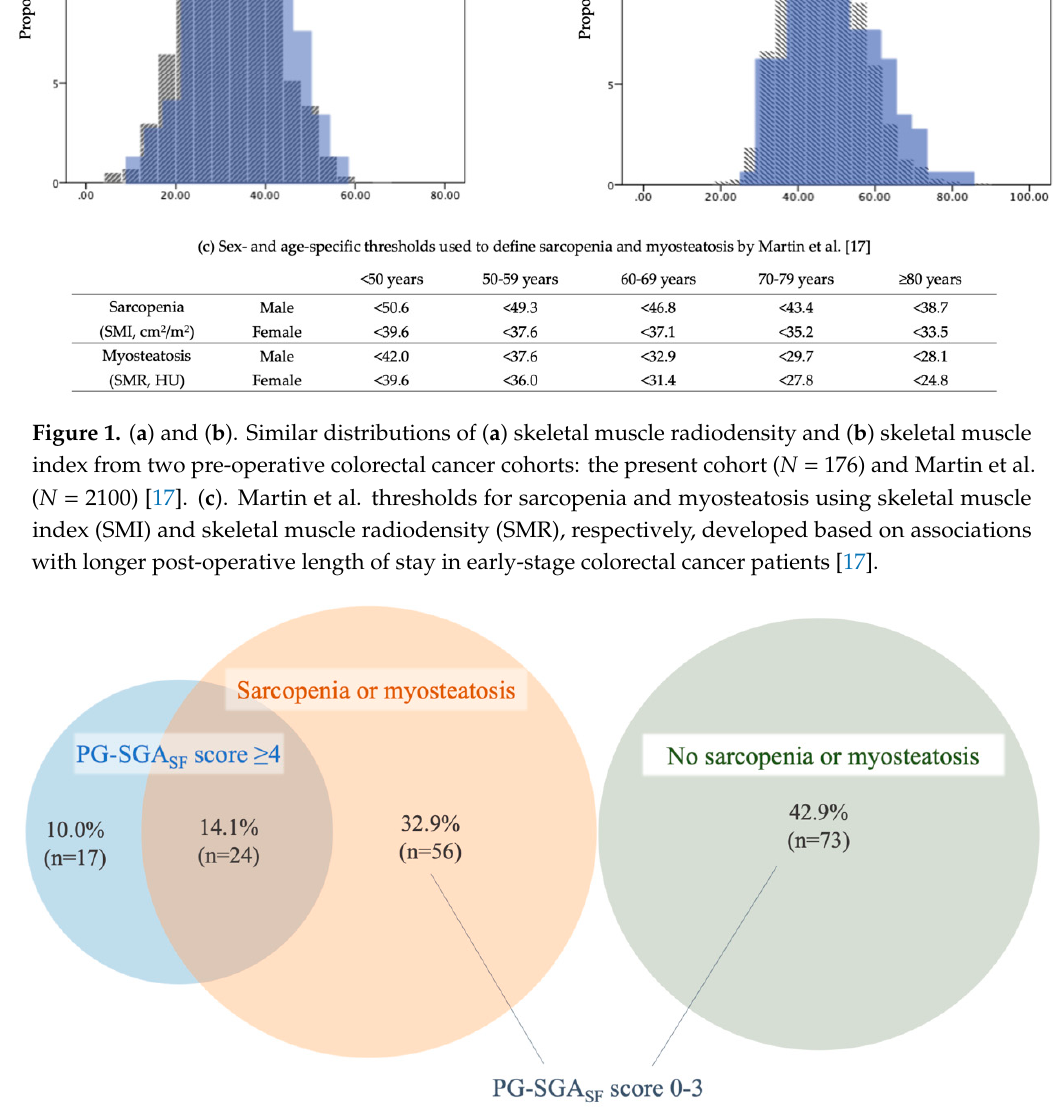
Figure 2. Proportional Venn diagram illustrating the co-existence of PG-SGA SF score ≥ 4 and sarcopenia or myosteatosis pre-operatively. Sarcopenia or myosteatosis co-existed with a PG-SGA SF score of 0–3 in 32.9% of the total